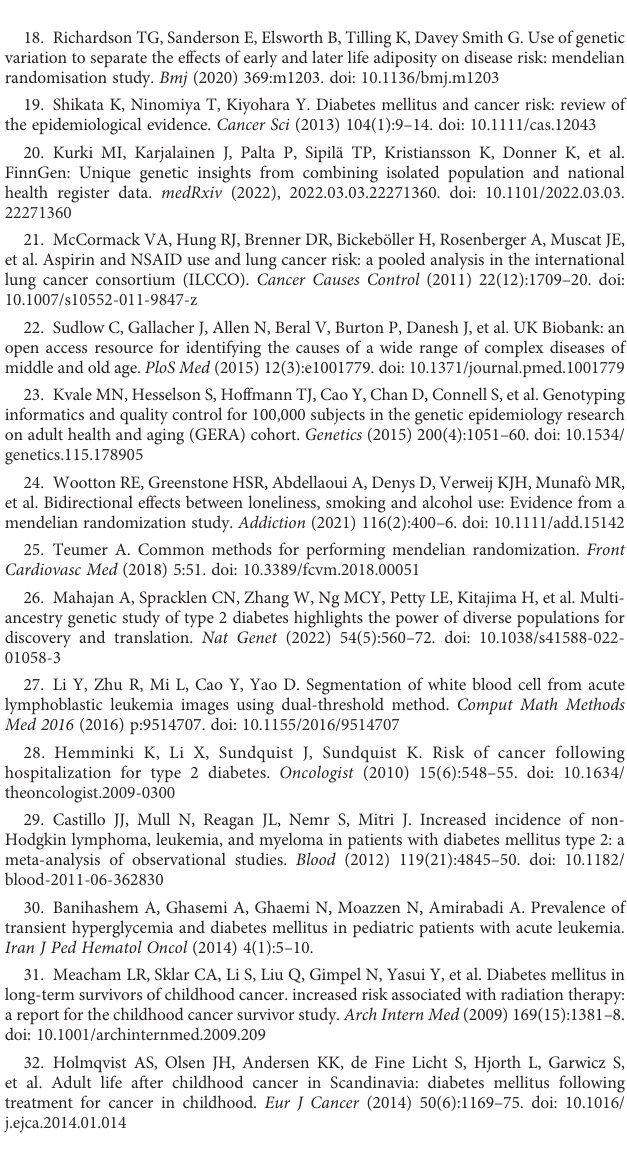
SUPPLEMENTARY TABLE 1 Information of GWAS summary datasets used in MR analyses. SUPPLEMENTARY TABLE 2 The F-statistics of IVs. SUPPLEMENTARY TABLE 3 MR analysis results. SUPPLEMENTARY TABLE 4 Heterogeneity test results. SUPPLEMENTARY TABLE 5 MR-Egger pleiotropy test results. SUPPLEMENTARY TABLE 6 MR-PRESSO test